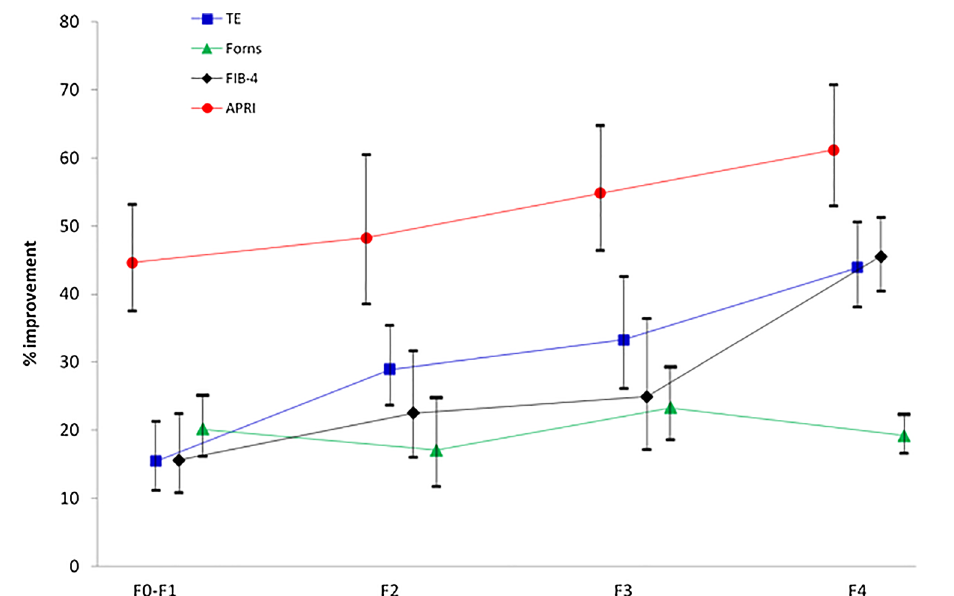
Figure 3. Improvement in the 24 month vs baseline measurements of non-invasive liver fibrosis markers in each baseline fibrosis stage (mean, 95%